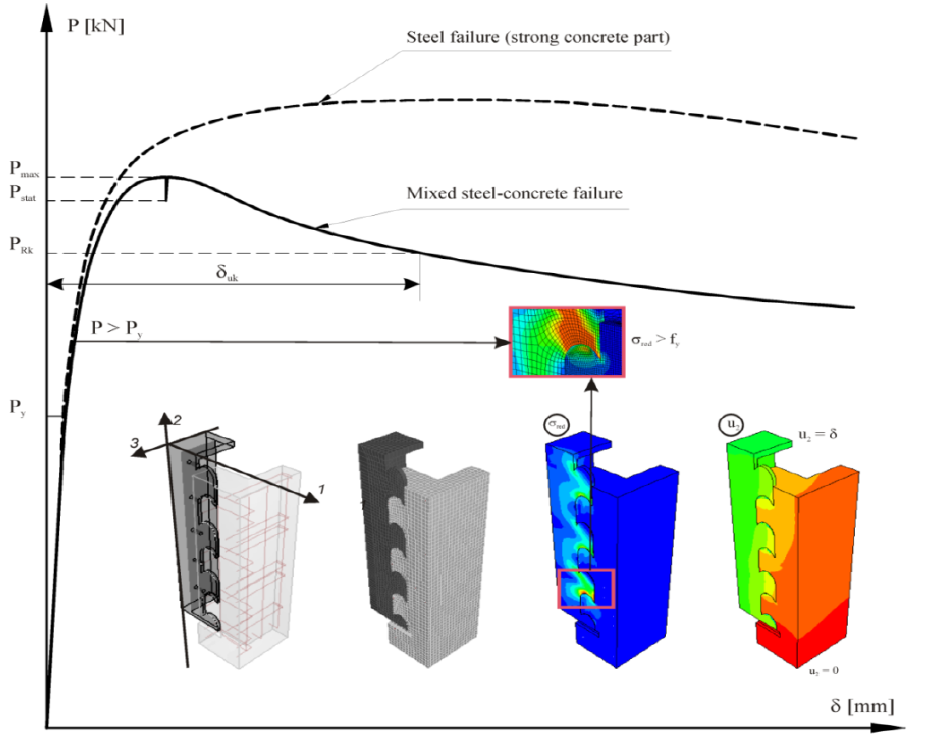
Figure 12: Illustration of the FE study of the push-out test [13].